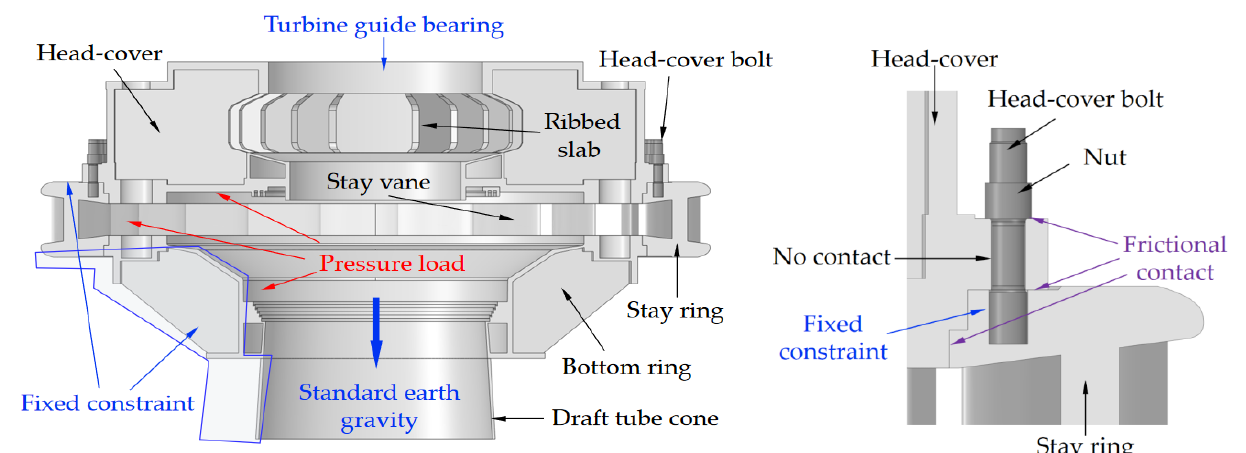
Figure 10. 3D model and the boundary conditions of the investigated structures.